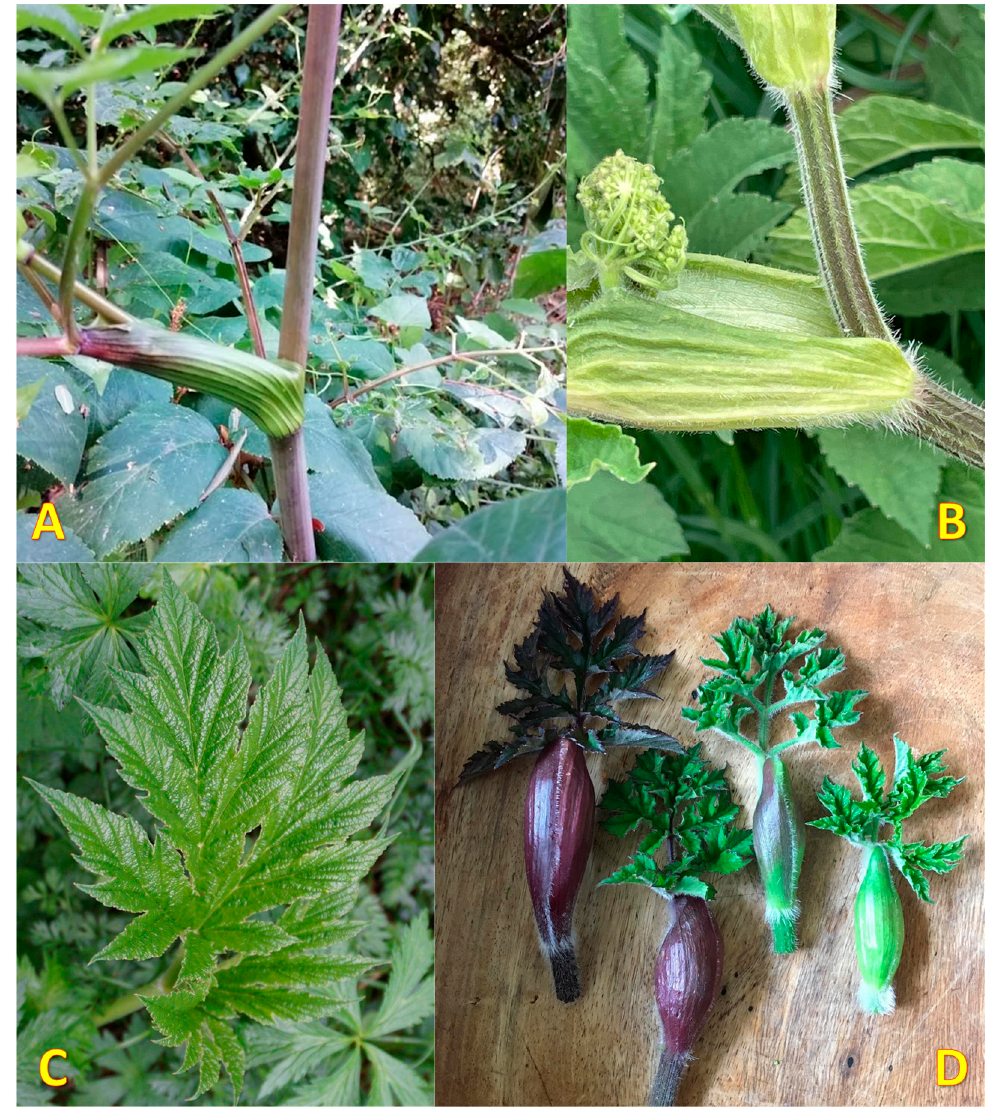
Figure 3. Plant details of H. sphondylium : stem ( A , B ); leaves ( C ); and shoots ( D ). Pictures by Eleonora Matarrese.